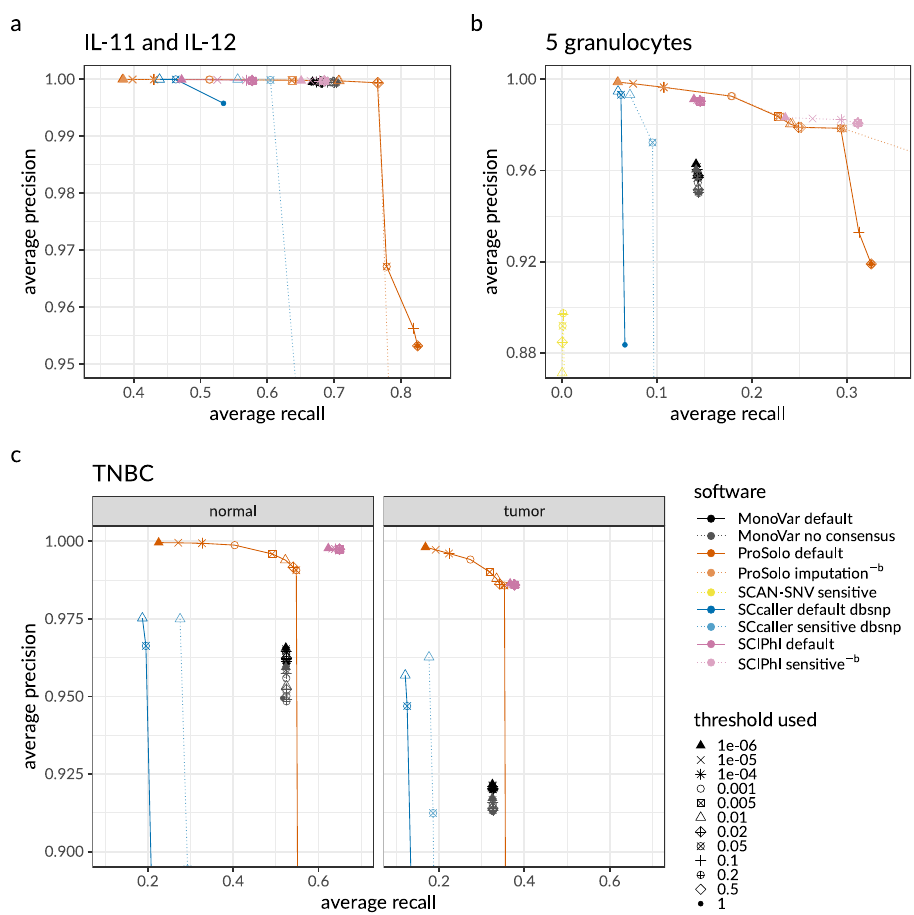
Fig. 1 Precision-recall plots for alternative allele calls of ProSolo, MonoVar, SCAN-SNV, SCcaller, and SCIPhI. All panels are strong zoom-ins, focusing on (different) areas of interest. Global views of these panels are provided in Supplementary Fig. 7. a Precision and recall of an average of two whole genome sequenced single cells IL-11 and IL-12 against their kindred clone IL-1C as ground truth genotypes. b Precision and recall average of the fi ve whole- exome sequenced single granulocytes against their pedigree-based germline genotype ground truth. c Precision and recall average of 16 tumor and 16 normal single cells sequenced at the whole exome level. − b The germline ground truth induces an arti fi cial increase of recall for SCIPhI ’ s sensitive and ProSolo ’ s imputation mode; these modes should thus be disregarded for a fair comparison on the granulocyte dataset in panel b . Threshold parameters (not comparable across tools): MonoVar --t; ProSolo --fdr; SCAN-SNV --fdr; SCcaller -a cutoff; SCIPhI prosolo --fdr. Software modes: MonoVar with consensus fi ltering (default) or without (no consensus); ProSolo with minimum coverage 1 in single-cell (default), or imputing zero coverage sites based on bulk sample (imputation); SCcaller with recommended settings (default) or with a more sensitive calling; SCIPhI with default parameters (default) or all heuristics off